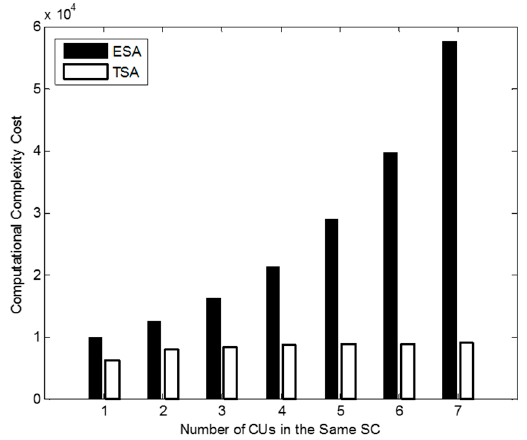
Figure 4. Computational complexity cost comparison of the tree-based search algorithm and the exhaustive search algorithm with ∆ = 0.01 . Algorithm 2 Tree-based Search Power Allocation Algorithm (TSA)